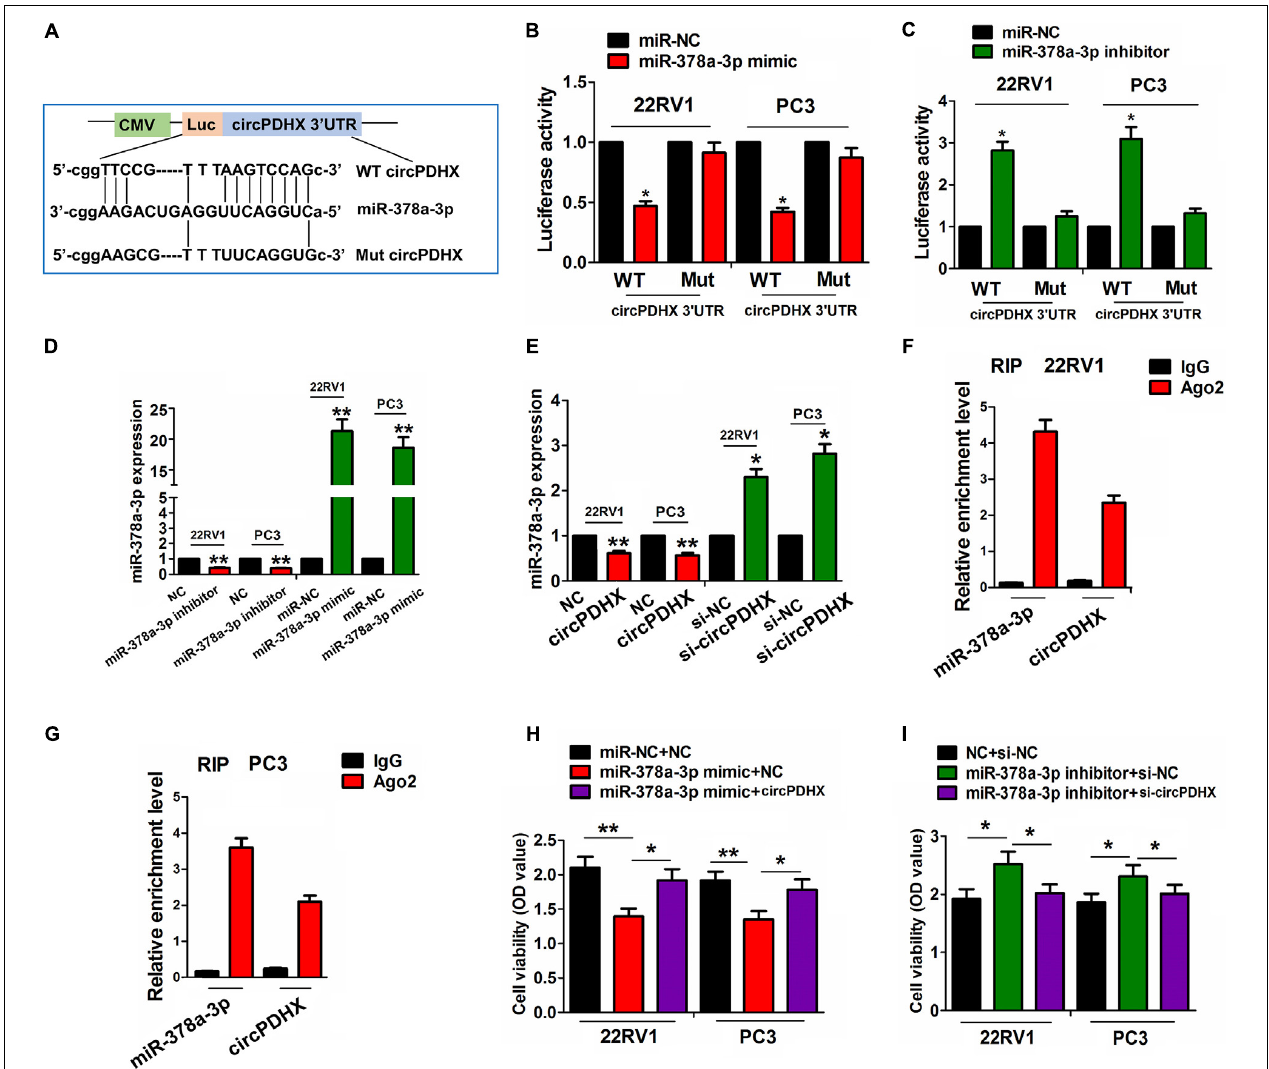
FIGURE 5 | circPDHX negatively regulated miR-378a-3p expression in prostate cancer (PCa) cells. (A) Schematic representation of the binding sites of miR-378a-3p with WT or Mut circPDHX 3 (cid:48) untranslated region (UTR). (B,C) Assessment of luciferase activities of WT or Mut circPDHX 3 (cid:48) UTR after cotransfection with miR-378a-3p mimic or inhibitor and WT or Mut circPDHX 3 (cid:48) UTR reporter vectors in 22RV1 and PC3 cells. (D) Quantitative real-time PCR (qRT-PCR) analysis of the expression levels of miR-378a-3p after transfection with miR-378a-3p inhibitor or mimic in 22RV1 and PC3 cell lines. (E) qRT-PCR analysis of the expression levels of miR-378a-3p after transfection with circPDHX plasmids or si-circPDHX in 22RV1 and PC3 cell lines. (F,G) RNA immunoprecipitation (RIP) analysis of the enrichment levels of circPDHX and miR-378a-3p pulled down from Ago2 protein in 22RV1 and PC3 cells. (H,I)